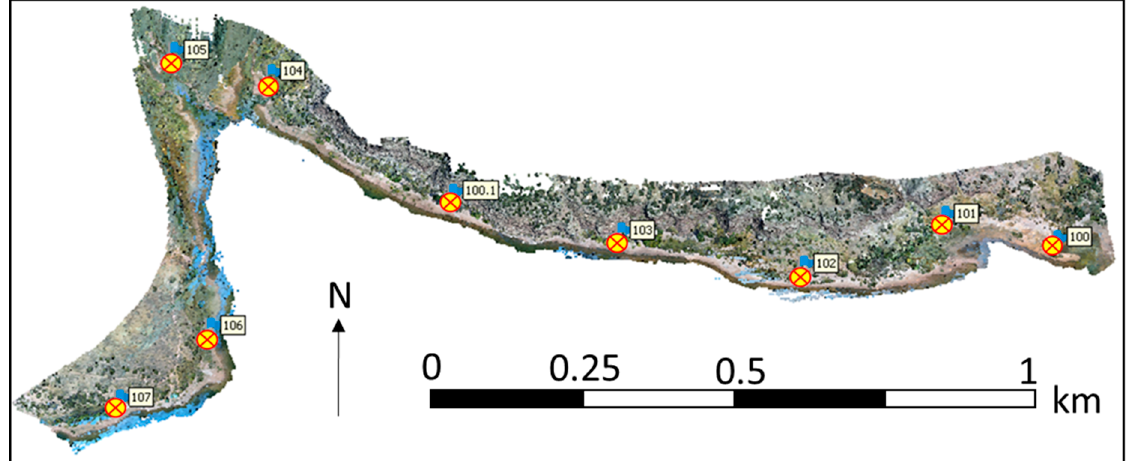
Figure 5. Northeast Starvation Reservoir test site with ground control points (GCPs) represented by yellow and red dots on the shoreline.